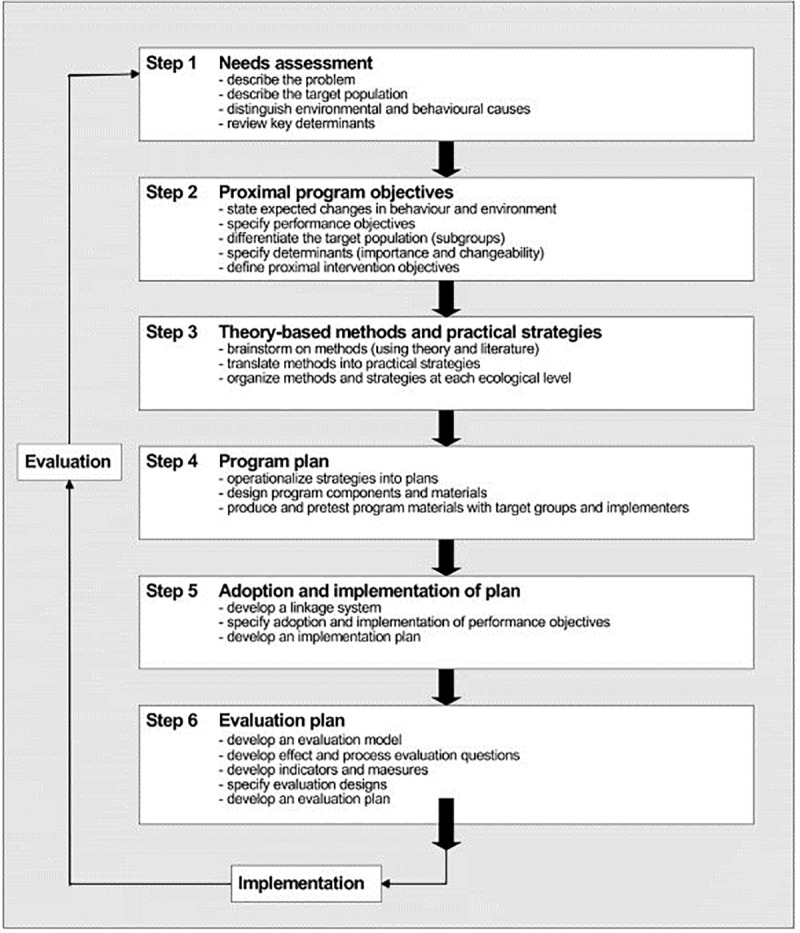
The six steps of the Intervention Mapping process [20].